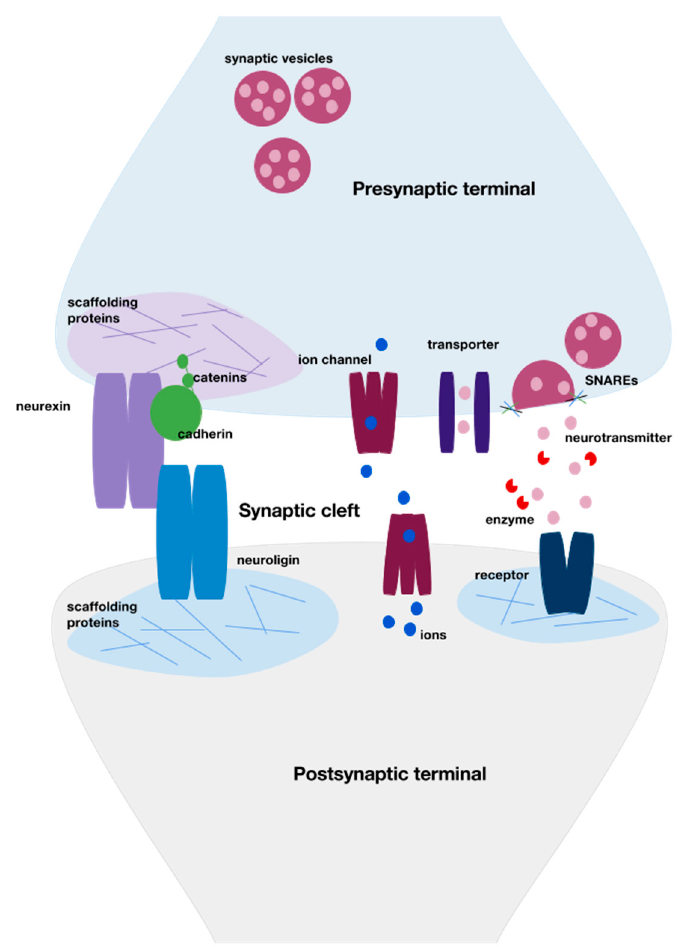
plasma membranes. Neurotransmitter left in the synaptic cleft is then taken up into the presynaptic terminal by plasma membrane transporters, while empty SVs are recycled via clathrin-mediated endocytosis [8] (Figure 1).